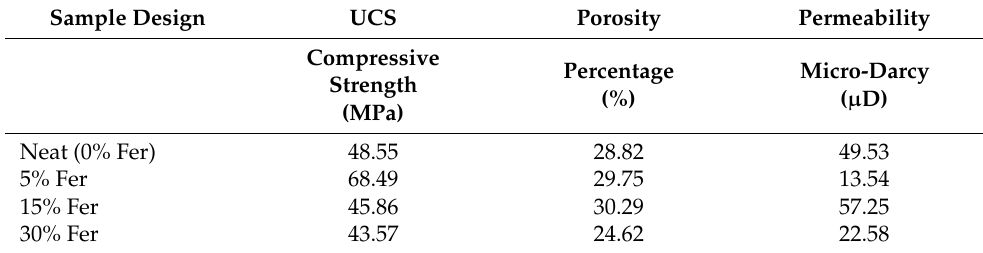
Table 4. Summary of compressive strength and petrophysical tests for 16.4 ppg neat Class-H, and 5%, 15% and 30% ferrierite-added Class-H cement